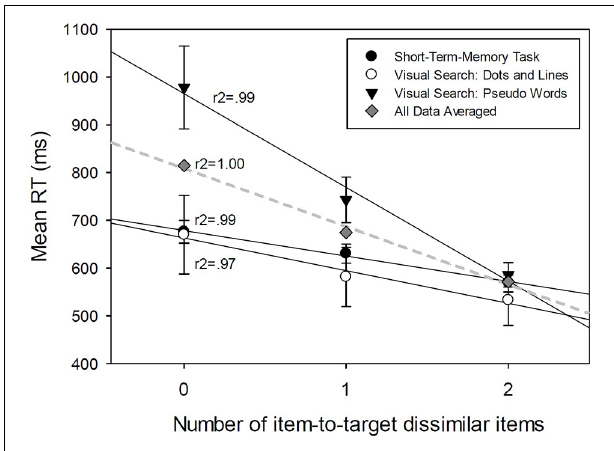
FIGURE 4 | Linear regression analyses between Mean RT averaged across the subjects and the number of item-to-target dissimilar items in a search set, for different experimental